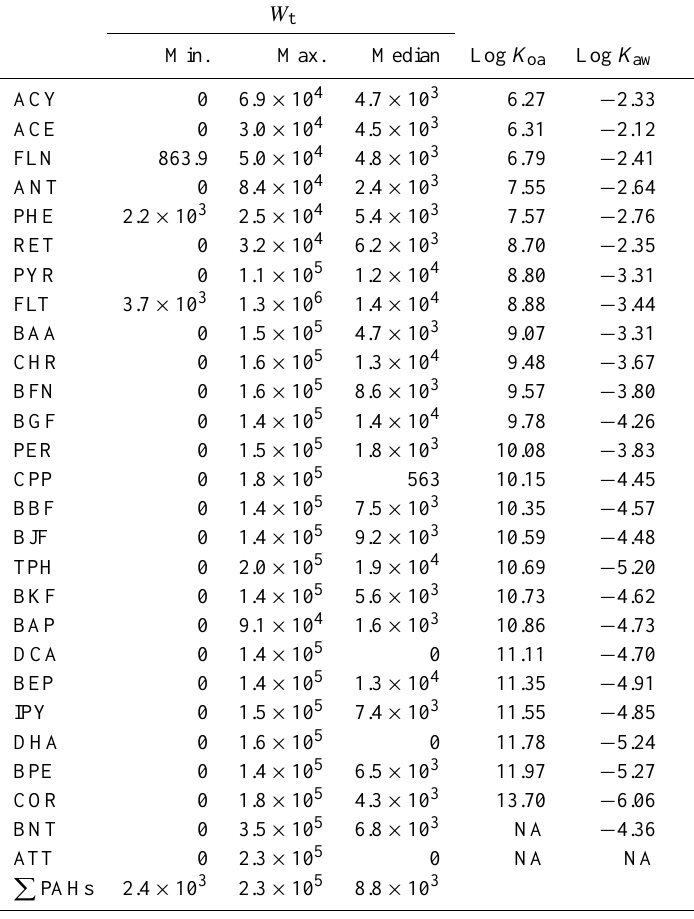
Table 5. PAH scavenging ratios ( W t )